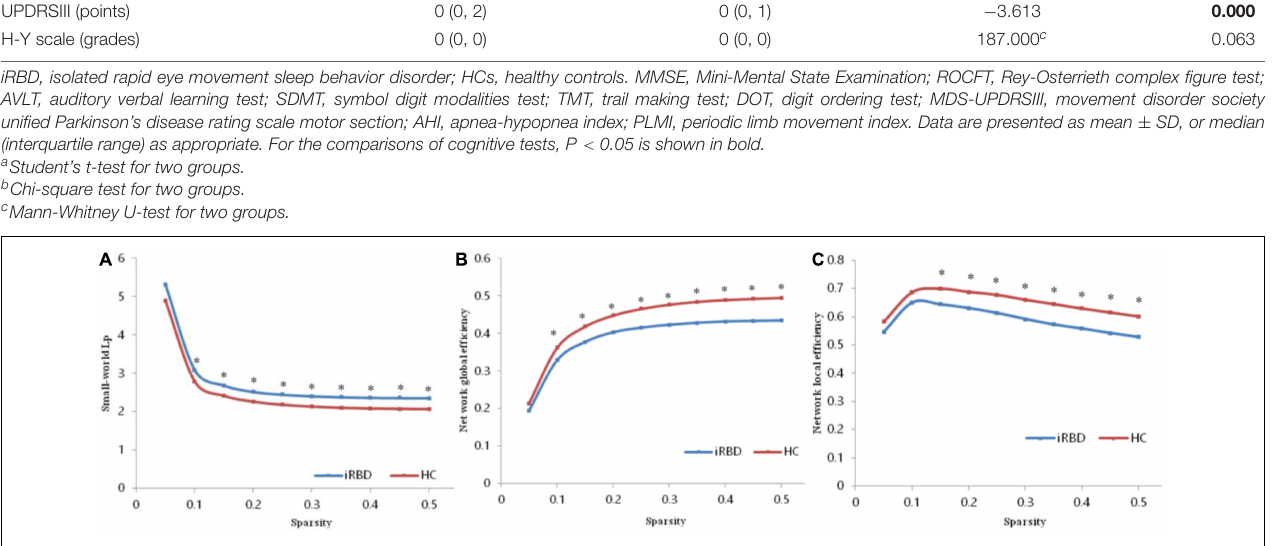
FIGURE 1 | Altered global topological parameters of the functional connectome across different sparsity thresholds (0.05–0.50). (A) Small-world Lp of the functional connectome. (B) Network global efficiency of the functional connectome. (C) Network global efficiency of the functional connectome. Black stars indicate where the difference between patients with iRBD and HCs was significant ( P < 0.05). iRBD, isolated rapid eye movement sleep behavior disorder; HC, healthy